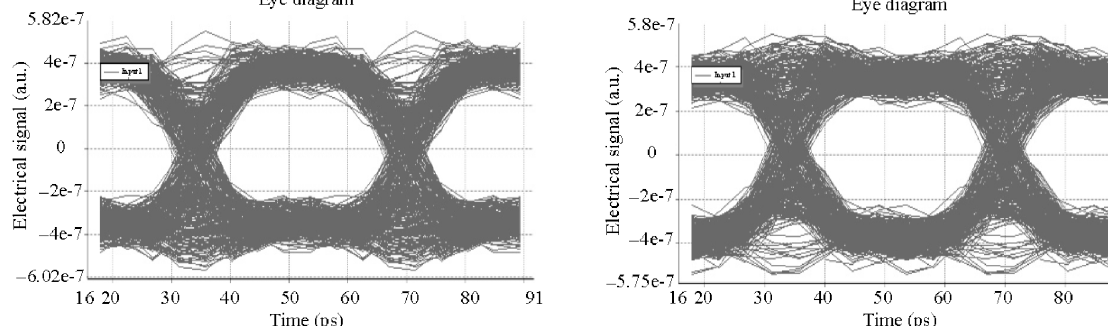
Fig. 4 Eye diagram of the DQPSK payload after 120-km transmission for I and Q branches.